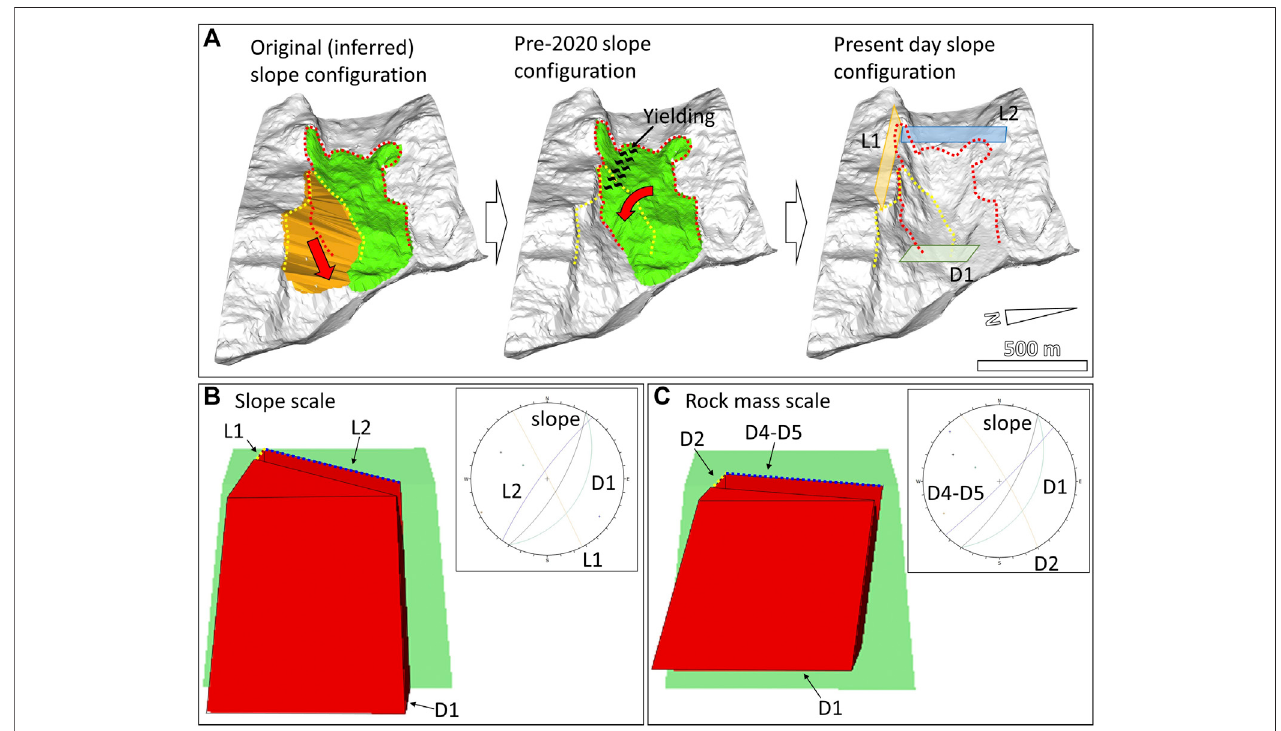
FIGURE 9 | Summary of kinematic analysis of the rock slope. (A) evolutionary block model of the landslide. Yellow and red dotted curves outline the boundaries of the old and 2020 landslide event, respectively. Red arrows represent the inferred displacement direction of the landslides. The orange block represents the older, undated landslide that affected the slope. Block morphology was reconstructed by interpolating a surface across the edges of the old landslide scar. The green block represents the volume detached during the 2020 event. Block morphology was built using the pre-failure LiDAR dataset. Note the inferred torsional component inferred for the block, produced by the asymmetric kinematic constraint in the lower slope, and the inferred area of rock mass yielding kinematically required for the movement to occur. The present-day slope con fi guration conceptually displays the slope-scale structures that controlled the 2020 landslide and were included in the slope scale kinematic analysis shown in (B) . (B) results from the slope-scale SWedge analyses using D1 as basal surface and lineaments L1 and L2 as lateral and rear releasesurfaces,respectively. (C) results from therock massscaleSWedge analysesusing D1as basalsurfaceand discontinuity sets D2, and D4 and D5aslateral and rear release surfaces, respectively. The average, pre-2020 failure slope orientation was used for the model